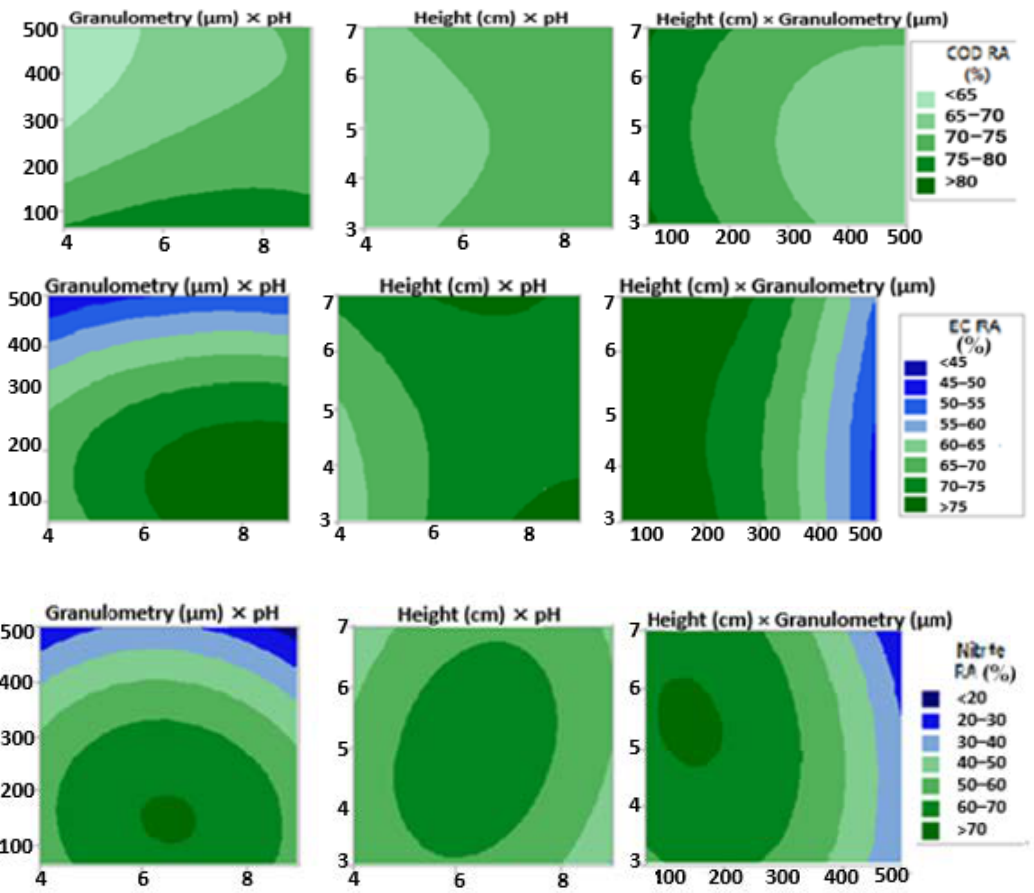
Figure 8. Contour diagram showing the effects of pH, particle size and bed height.